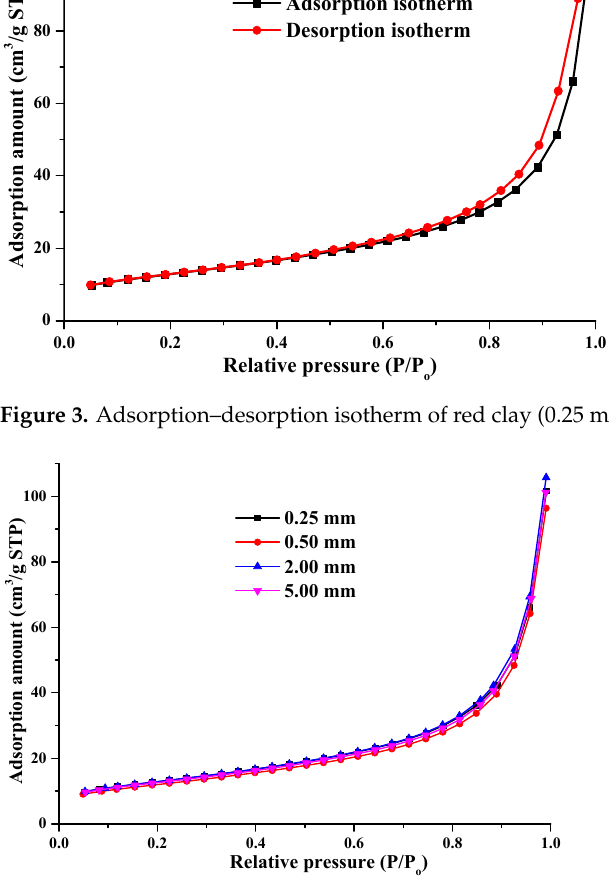
Figure 4. Adsorption isotherms of red clay with different particle sizes. Table 4. The SSA of red clay with different particle sizes.